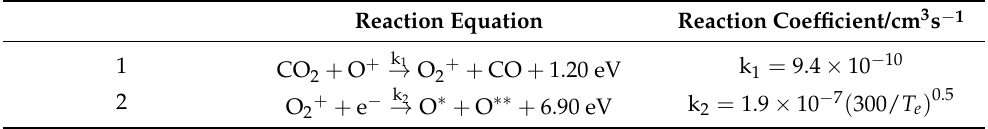
Table 1. Chemical reaction equation of CO 2 in the